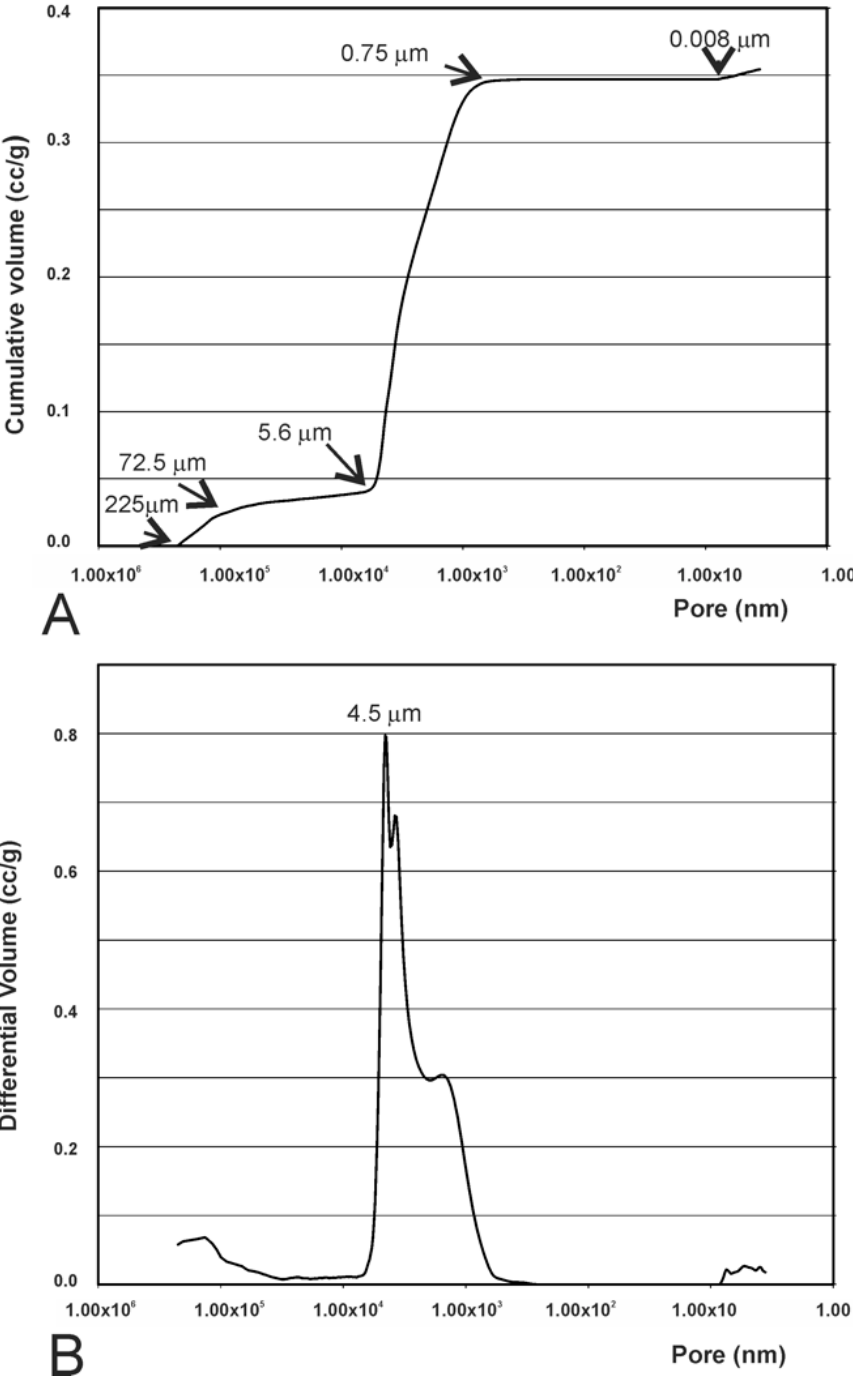
Figure 5. ( A ) Mercury intrusion curves of the synthetic TCP measured by mercury porosimetry: cumulative intruded volume vs. pore diameter and ( B ) differential-intruded volume vs. pore diameter.